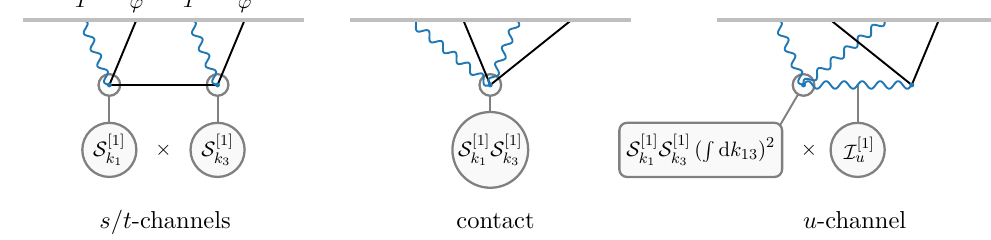
Figure 6. Illustration of the transmutation operators for the graviton Compton